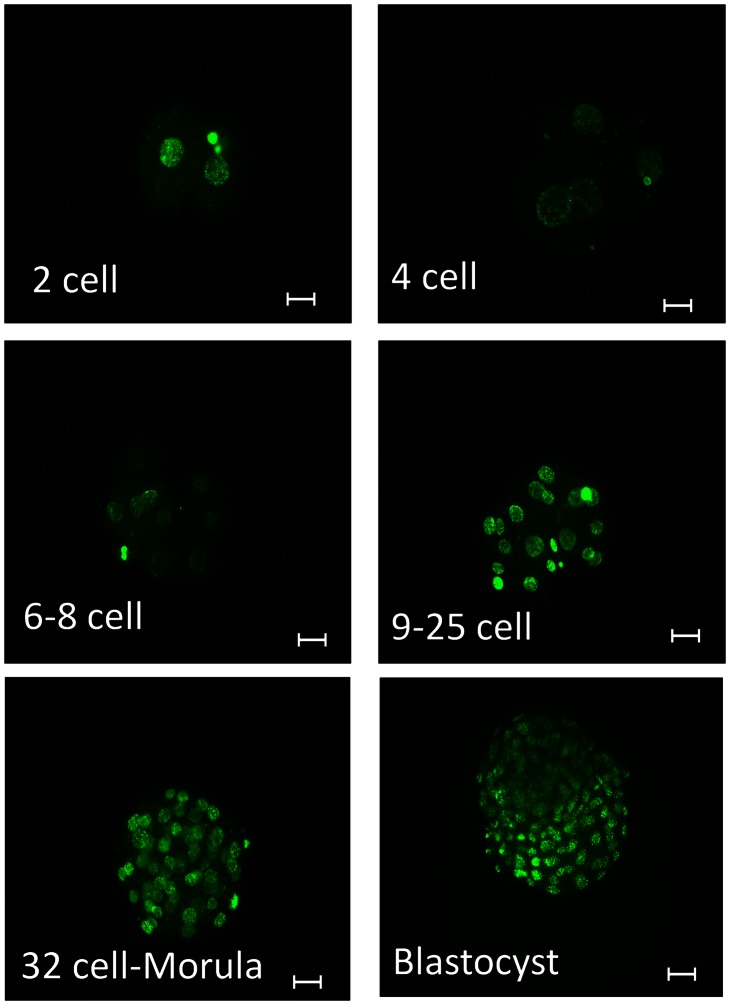
Representative images of embryos labeled for immunoreactive 5- methylcytosine at the 2 cell, 4 cell, 6–8 cell, 9–25 cell, 32 cell-morula and blastocyst stages of development.The scale bar represents 26.75 µm.